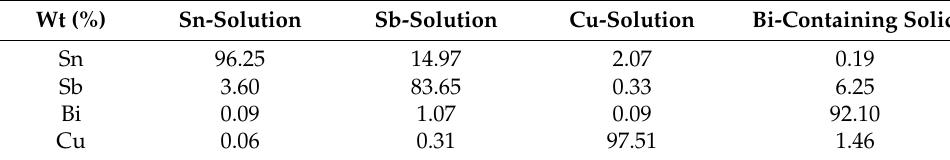
Table 7. Components of Sn, Sb, Cu solutions and Bi-containing solid.